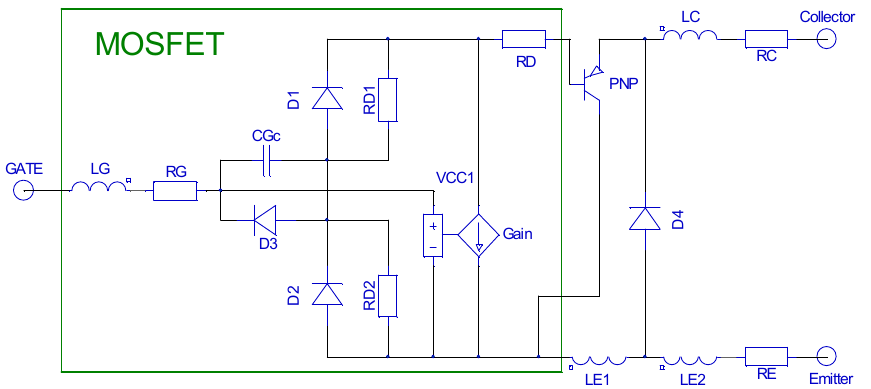
Figure 2. Equivalent circuit model of the IGBT (Insulated Gate Bipolar Transistor). Diodes D1 and D2 describe the current change directly in the p–n junctions, and diode D3 describes the change in capacitance caused by a change in the excitation of the adjacent semiconductor layers of the gate. Since the gate is placed in a SiO2 (dielectric) environment, its magnitude should not change. However, as shown in Figure 3, where the topological structure of the IGBT transistor is given, the total gate capacitance consists of a constant component (gate capacitance to the emitter metal CGc Figure 2) and a variable part (D3 describes this capacitance) that is created when the gate interacts with a semiconductor structure (n+, p − , n − , p − , n+). The conductivity of these layers varies from almost fully insulated to fully